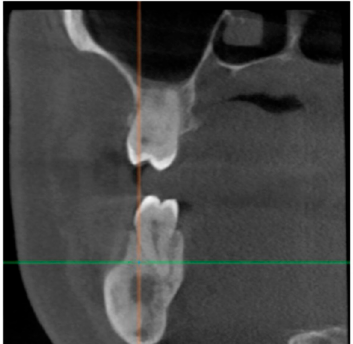
Figure 5. CBCT image of the bone healing process in the tooth #47 periapical area